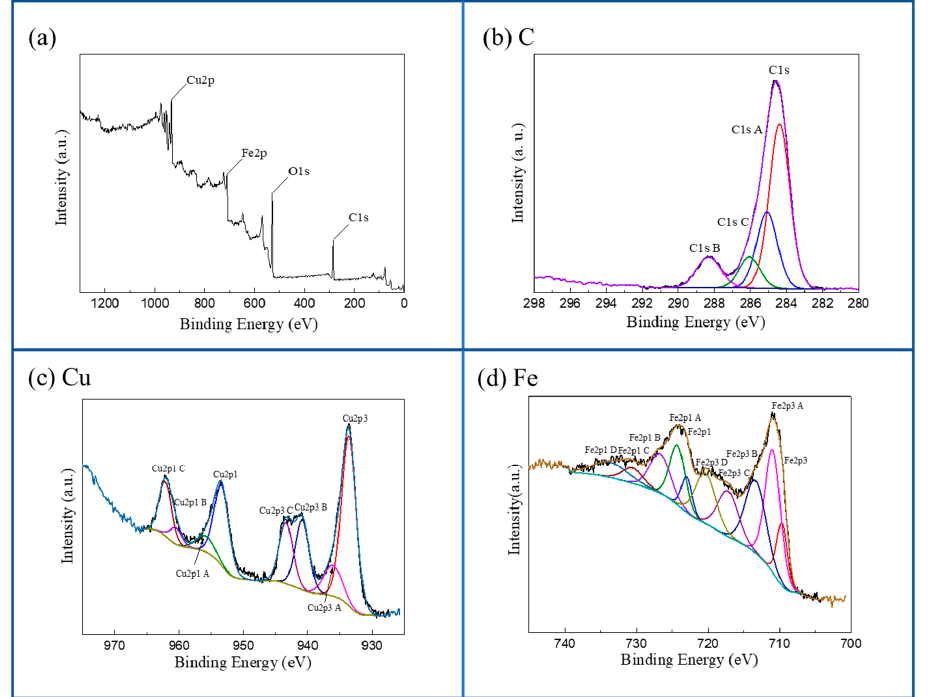
Figure 2. ( a ) High-resolution X-ray photoelectron spectroscopy (XPS) survey spectra of the carbon-doped CuO/Fe 3 O 4 composite catalysts. ( b ) High-resolution XPS scans over C 1s peaks of the carbon-doped CuO/Fe 3 O 4 composite catalysts. ( c ) High-resolution XPS scans over Cu 2p peaks of carbon-doped CuO/Fe 3 O 4 composite catalysts. ( d ) High-resolution XPS scans over Fe 2p peaks of carbon-doped CuO/Fe 3 O 4 composite catalysts.